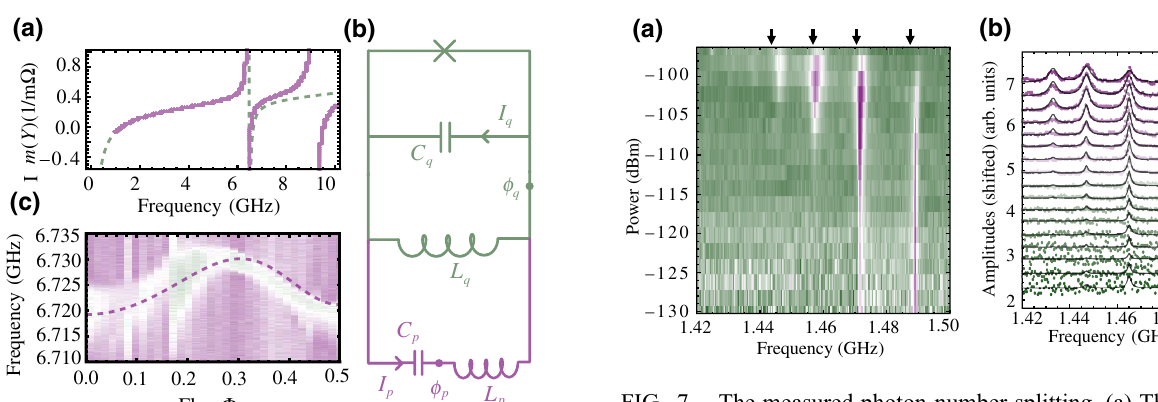
FIG. 7. The measured photon-number splitting. (a) The spec- troscopy of qubit C as a function of the measurement power. The arrows indicate the solution of the full Hamiltonian. (b) Individual measurement traces from (a) plotted with an offset for visibility. The black lines correspond to fits to a Poissonian weighted sum of